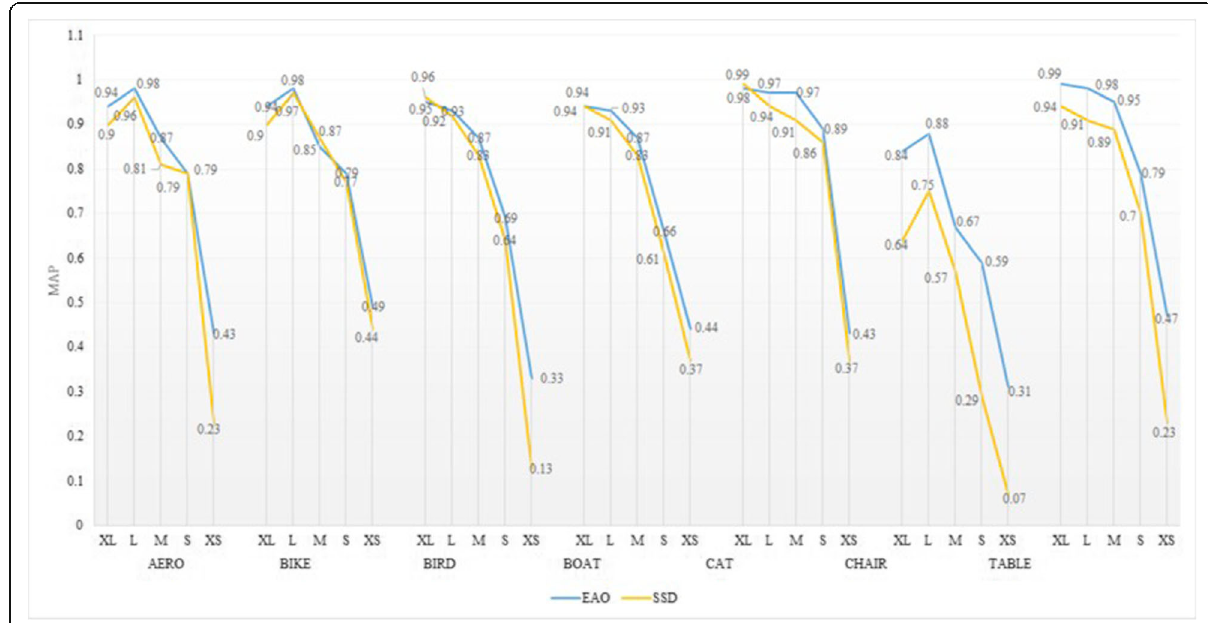
Fig. 5 The results of the bounding box detector demonstrate an imbalance between the classes. Each column represents a comparison of the number of borders for each class using different intersections within a 10% to 90% joint threshold range. SENET and SSD models are used to compare the accuracy of identifying objects of different sizes. The overall performance of SENET model is better than that of contrast model, and the recognition accuracy of chair with sparse structure is much higher than that of SSD